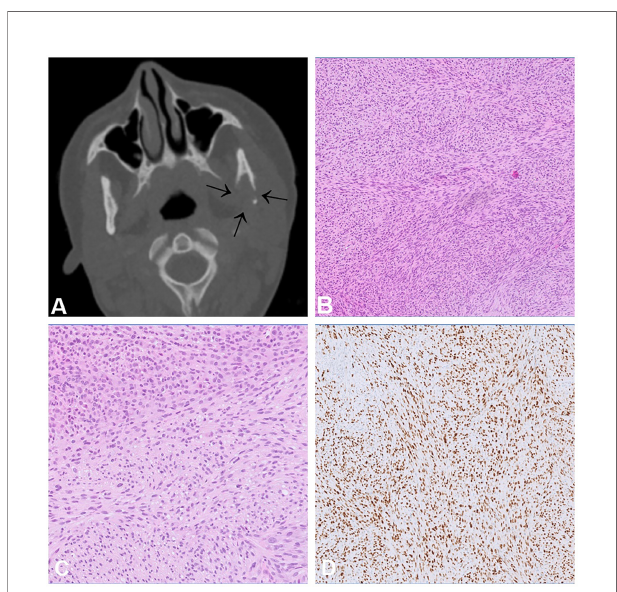
FIGURE 5 | Rhabdomyosarcoma with TFCP2 rearrangement. (A) CT scan showing an aggressive and destructive tumour in the articular process of the left mandible. (B, C) Histologically, sclerosing rhabdomyosarcoma shows an admixture of spindle and epithelioid cells (C) arranged in solid fascicles with only scant stroma. (D) The tumour cells show diffuse positivity for